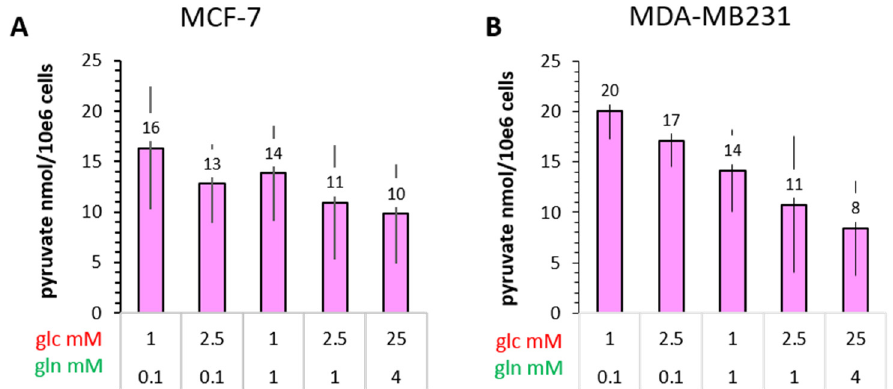
Figure 4. Uptake of [1- 14 C]pyruvate by MCF-7 and MDA-MB-231 cells in different glucose/gluta- mine conditions. Cells were cultured for 72 h in medium containing the indicated glutamine/glucose concentrations. 14 C-pyruvate uptake was measured for 15 s and normalized to the corresponding cell number. Data are averages with the s.e.m. from independent experiments ( n ). ( A ) MCF-7 n = 5; ( B ) MDA-MB-231 n = 3.